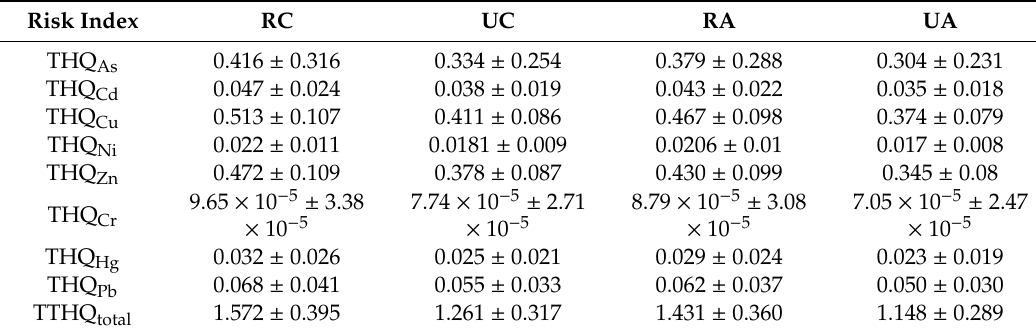
Table 8. The calculated results of the health risks of rural and urban adults and children. RA, RC, UA, and UC represent rural adults, rural children, urban adults, and urban children, respectively. Risk Index